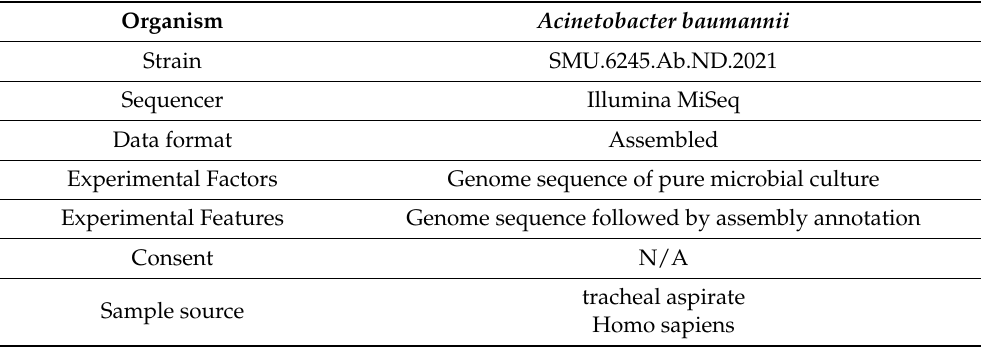
Table 1. Specification of investigated